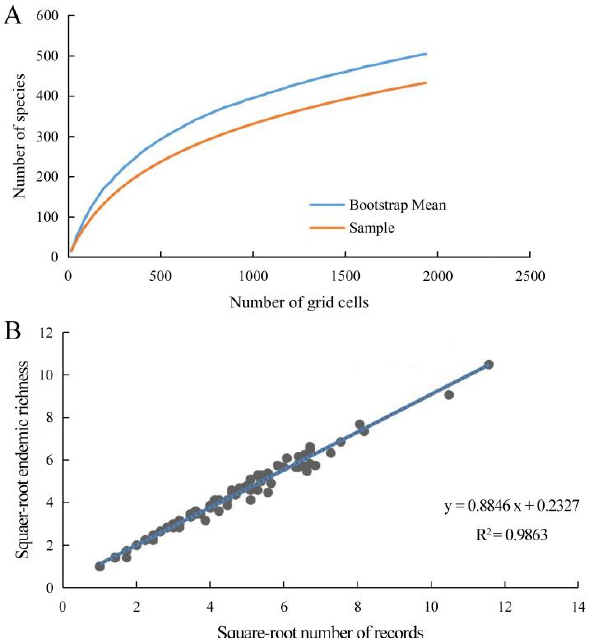
Figure 1. ( A ) Species accumulation curves for Tenebrionidae in Xinjiang, China. ( B ) Linear regression (y = 0.8846x + 0.2327) for the number of records and species richness in a 1° grid. The observed richness in the cells below the regression line was >69.3% of the predicted richness.